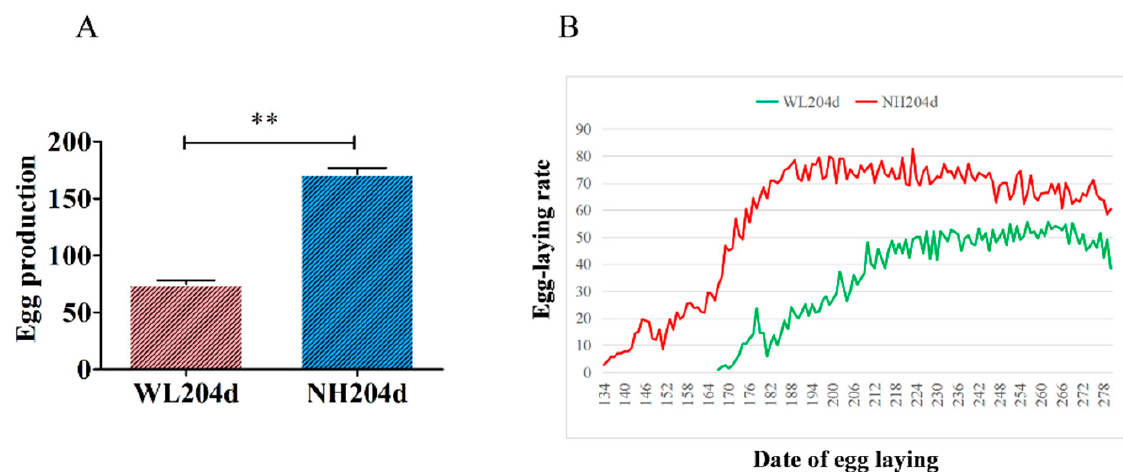
Figure 1. Analysis of egg production of different breeds of hens. ( A ) comparison of the average number of eggs laid by two breeds of hens over a statistical number of days. Data is shown as mean ± standard deviation (SD), ** indicates p < 0.01. ( B ) graphs of egg production rates of different breeds of hens, with horizontal coordinates representing days of laying and vertical coordinates representing egg production rates. The red curve represents the egg production rate of NH ( n = 300). The green curve represents the laying rate of WL ( n = 200).